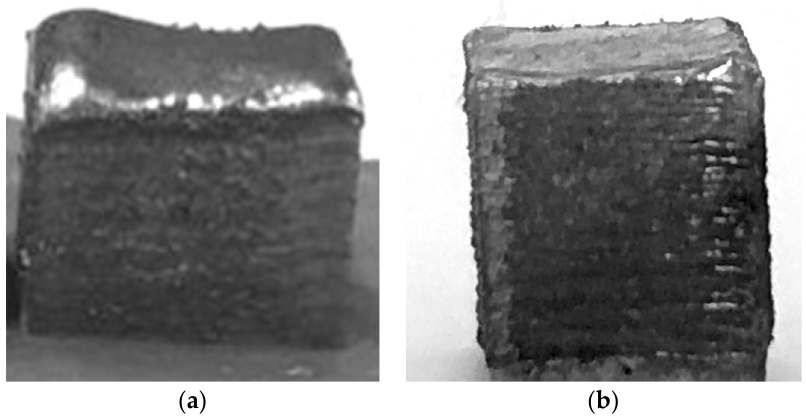
Figure 1. A sample prepared by selective laser melting from NiTi 50.7 alloy powder. ( a ) with VED = 173.6 J/mm 3 , parameter set 2 (Table 2); ( b ) with VED = 130.2 (×2) J/mm 3 , parameter set 4_2 (Table 3). Table 4. Density of samples made by selective laser